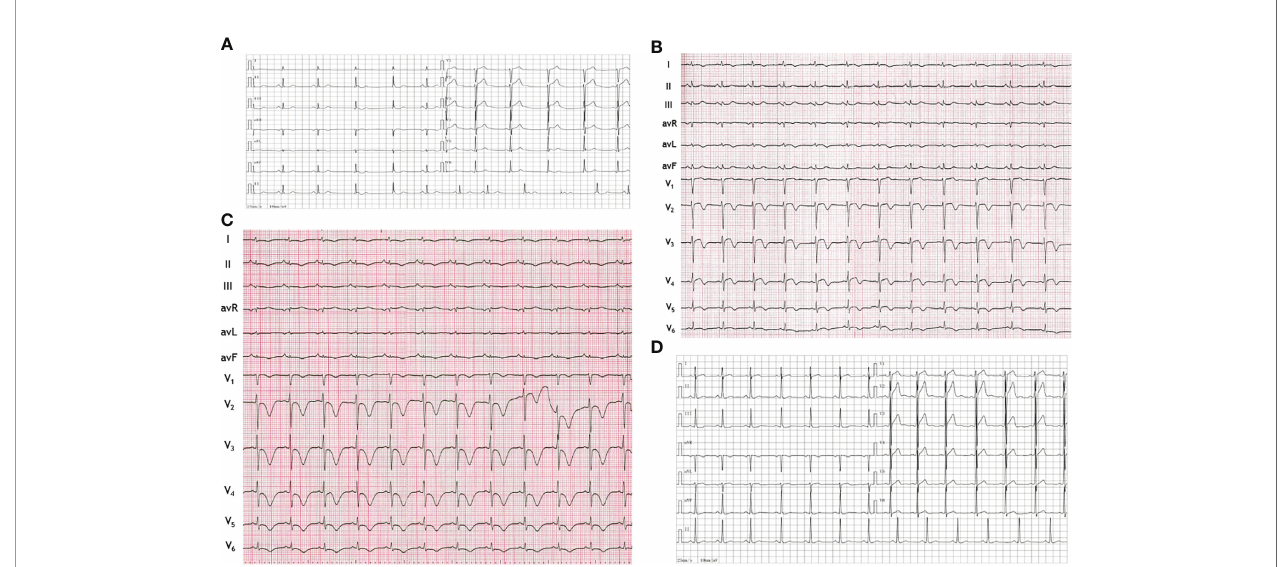
FIGURE 1 | Electrocardiograms. (A) Electrocardiogram obtained one month before this admission showed nearly normal. (B) Electrocardiogram at hospital admission showed QT prolongation and T-wave inversions in leads I and V1 to V6. (C) Electrocardiogram on the third hospital day showed more obvious QT prolongation and T-wave inversions in the limb leads (I, II, III, AVL, AVR and AVF) and the chest leads (V1 to V6). (D) Electrocardiogram after surgery showed QT prolongation and T-wave inversions